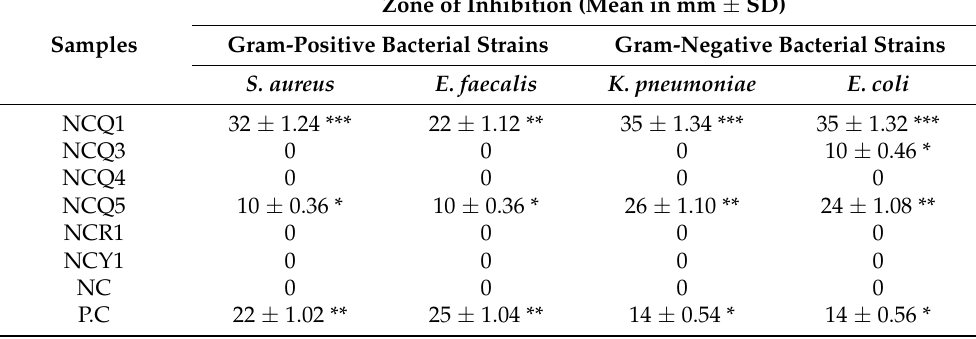
Table 8. Antimicrobial activity of different clay samples against Gram-positive and Gram-negative bacterial strains. Zone of Inhibition (Mean in mm ± SD) Gram-Positive Bacterial Samples